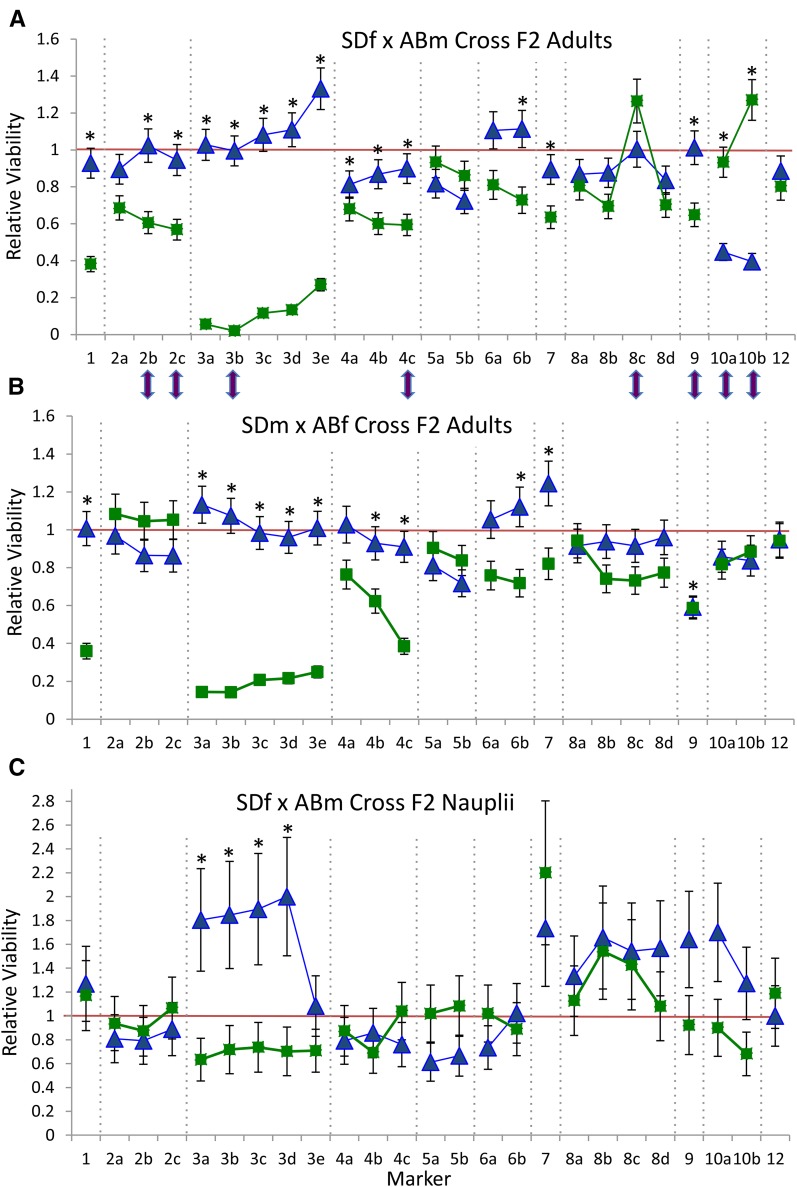
Relative viabilities of genotypes across iPlex markers in AB × SD F2 hybrids of T. californicus. Panel (A) shows the results for the F2 adults from the DA1 cross, (B) for the F2 adults from the AD1 cross, while (C) shows the results for F2 nauplii from the DA1 cross. Blue triangles give the relative viabilities of the AB/AB homozygous genotypic class in comparison to the expected 1:2 homozygote: heterozygote ratio, while green squares give the relative viabilities for the SD/SD homozygous genotypic class. The red line indicates the expected relative viability of one for each homozygote genotypic class. Relative viabilities and their SDs are calculated using Haldane’s (1956) formulation. An asterisk indicates a marker where genotypes differ significantly from the expected 1:2:1 ratio (P < 0.002 corrected P-value after applying a Bonferroni correction for 25 tests with α = 0.05 and 2 d.f.). Purple arrows show the markers for which there is a significant difference between the reciprocal crosses for genotypic ratios. This was tested in a 2 by 3 contingency table analysis with a critical P-value again of 0.002.